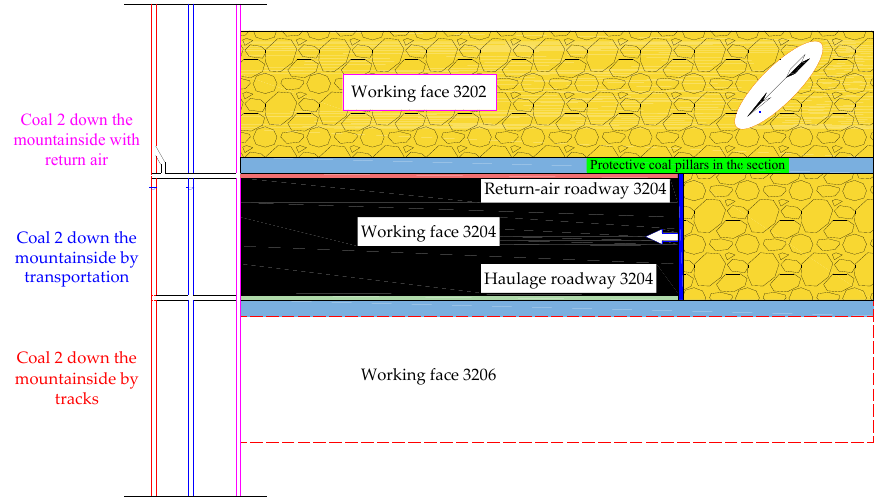
Figure 17. Roadway layout of working face 3204. The return-air roadway of working face 3204 is affected by high ground stress and mining. The surrounding rock of the roadway is extensively deformed. The displacement of the roof and floor can reach 200 mm while that of the coal side can reach 330 mm.